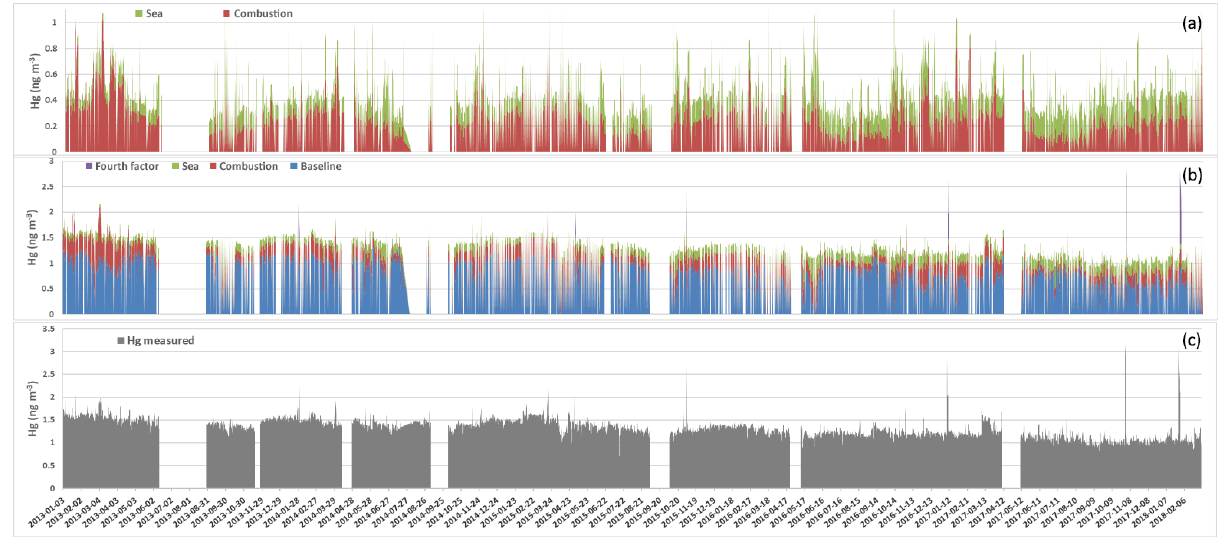
Figure 1. TGM hourly variations measured at Mace Head, from 2013 to 2018 (c) , time series of mercury attributed to each factor (b) , and time series of sea and combustion only (a)